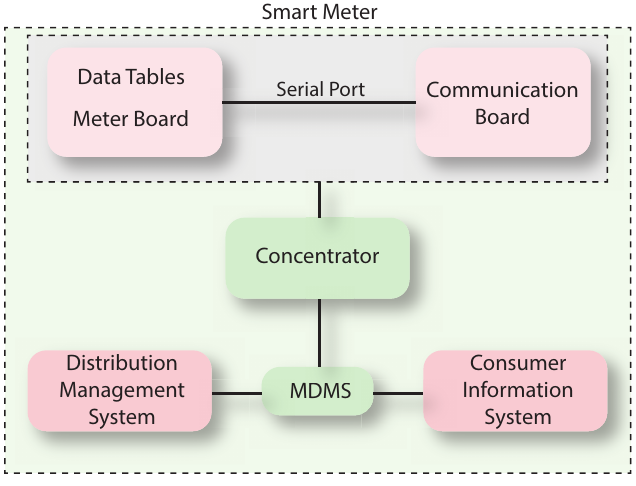
Figure 2. Advanced metering